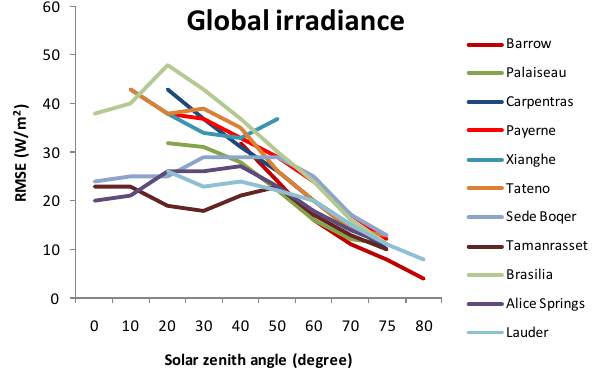
Fig. 15. Change in RMSE as a function of the solar zenith angle for all stations. Direct